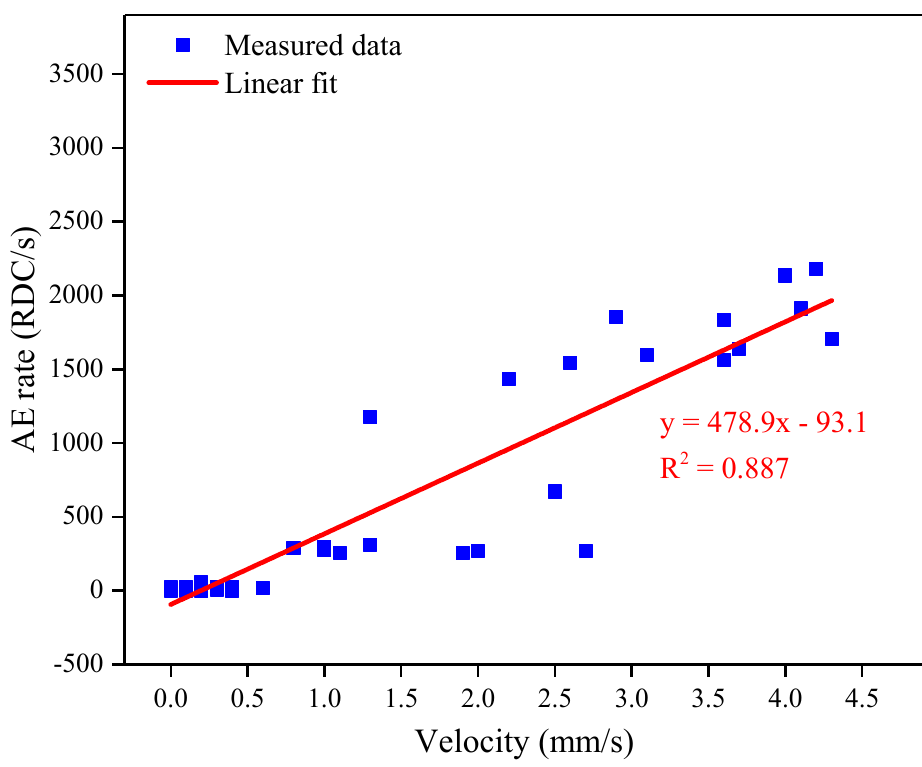
Figure 7. Linear fitting of sliding velocity and ring down